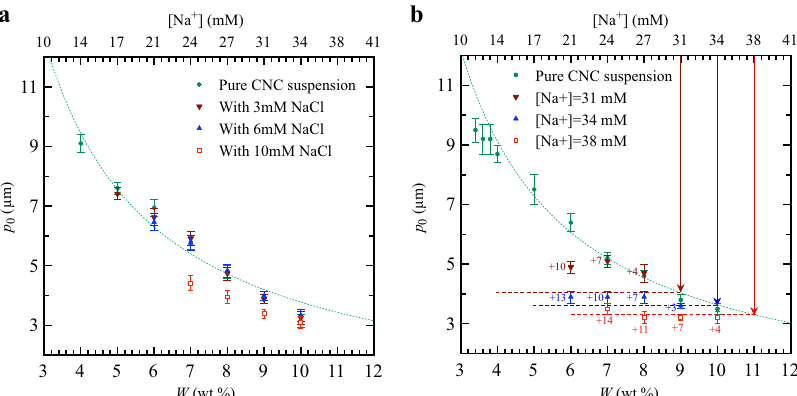
Fig. 5 Equilibrium helix pitch p 0 as a function of global CNC concentration W for suspensions enriched in long CNCs, without (green) and with varying concentrations of NaCl added. Panel ( a ) shows the result of adding the same amount of NaCl to all fractions, whereas panel ( b ) has different NaCl concentrations added to each sample (the amount in mM is indicated next to a data point) calculated such that a series has constant counter ion concentration, [Na + ]. The green line in each panel shows the best fi t of Eq. (2) to the data without salt addition. Error bars are standard deviations σ from n = 40 – 70 measurements in different [Na + ] = 34 mM (highlighted with a blue dashed horizontal line).